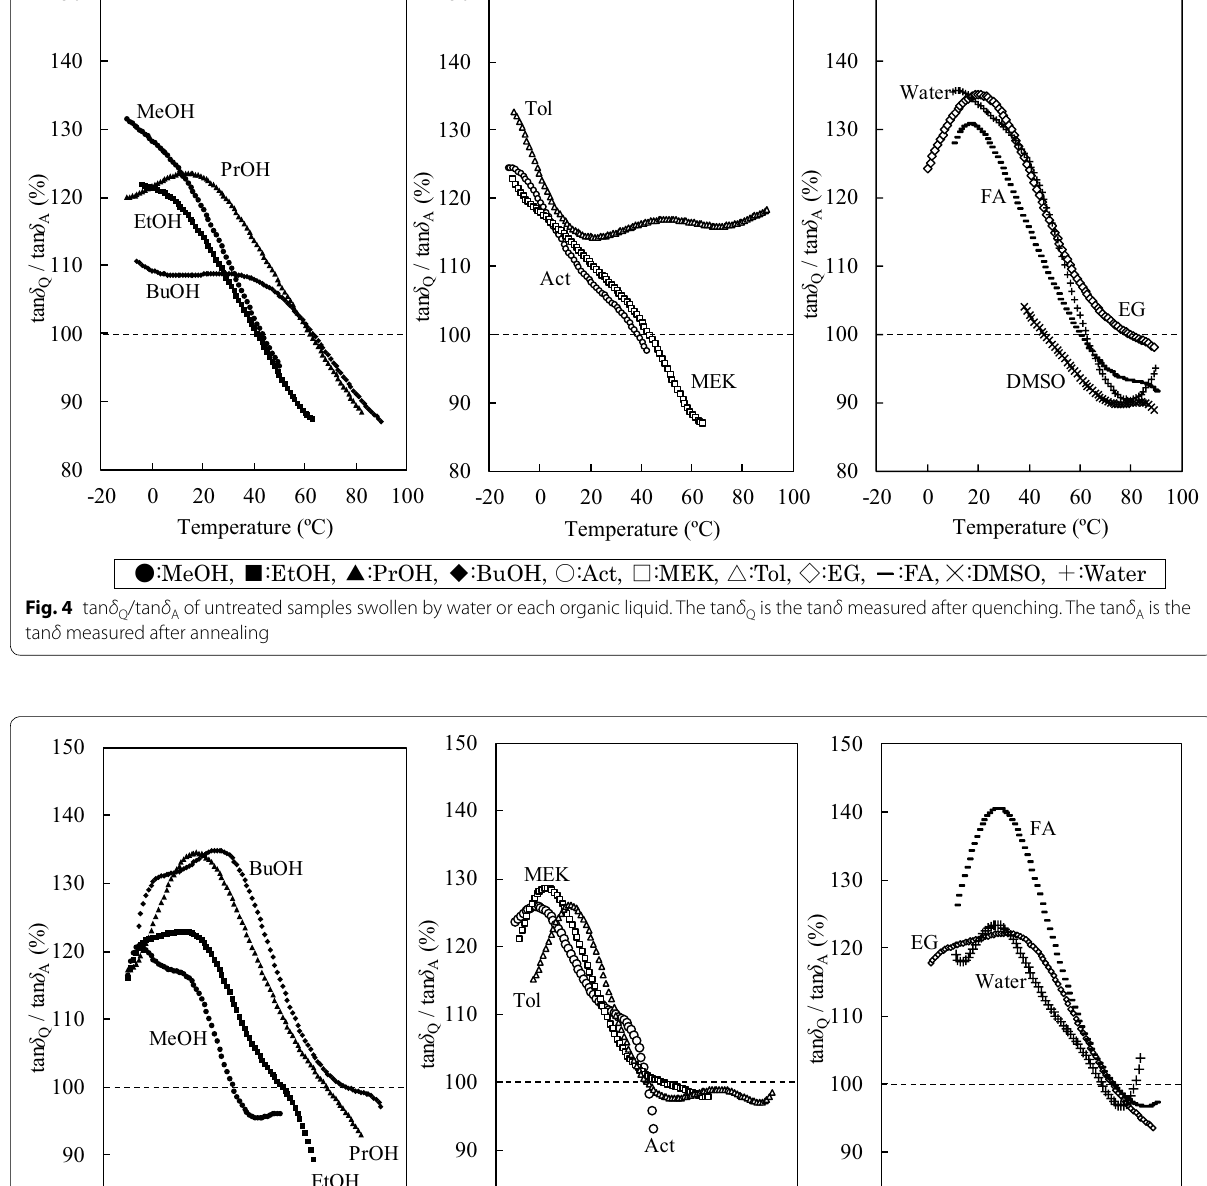
in the acetylated samples swollen by water or EG, when compared with the untreated samples. That is, a sample cooled from a temperature near the peak temperature of